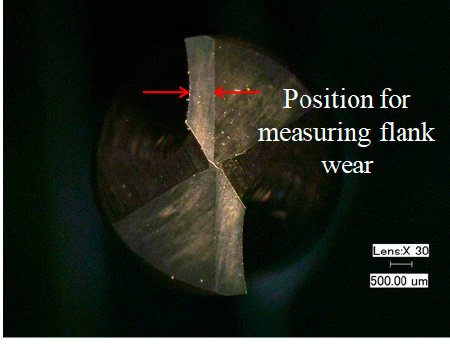
Figure 2. Measurement of tool flank wear.